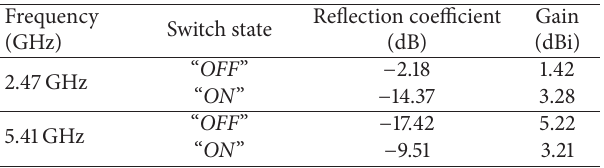
Table 1: Typical reconfigurable antenna parameters for the central frequencies of 2.4 and 5GHz bands.